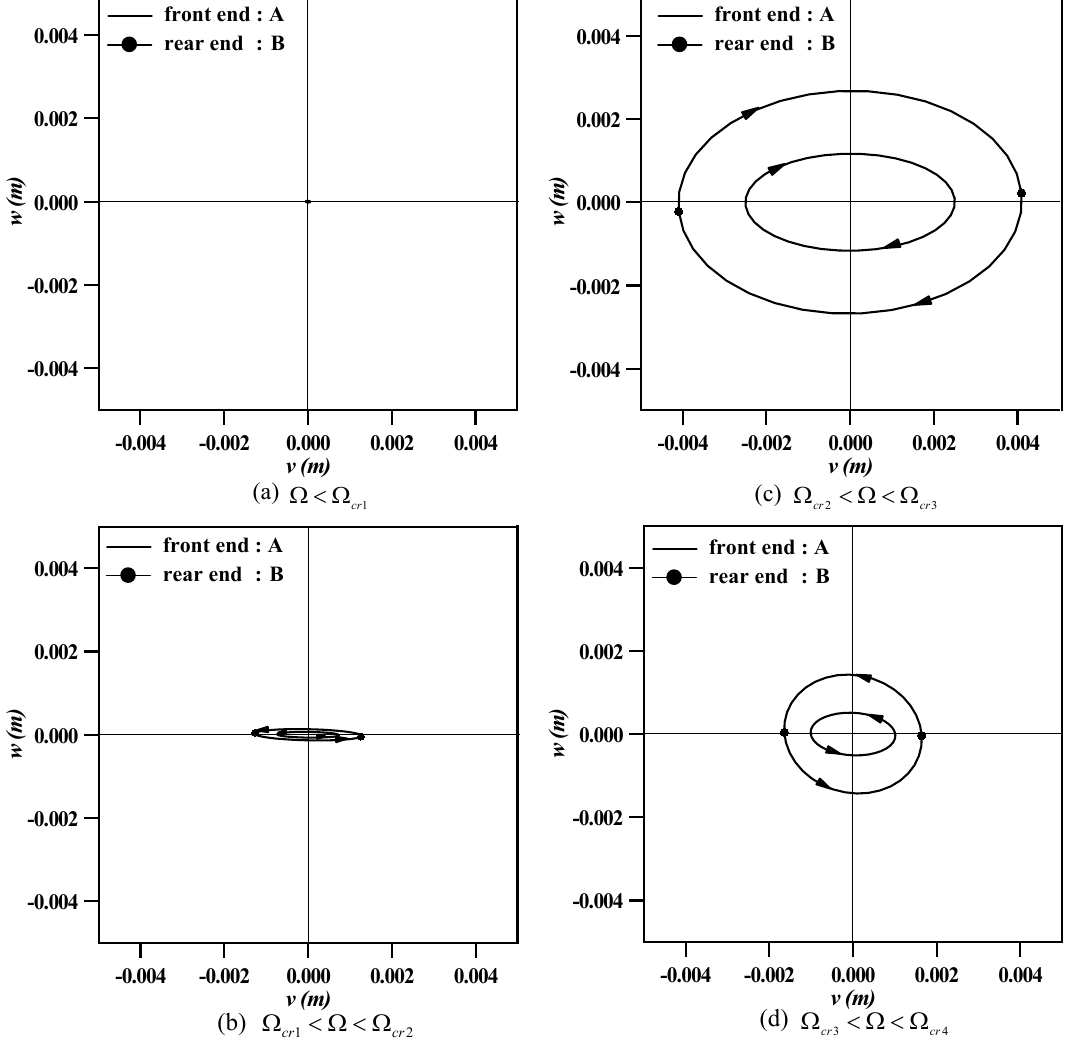
Fig. 10. Whirling orbits of local offset for different rotational